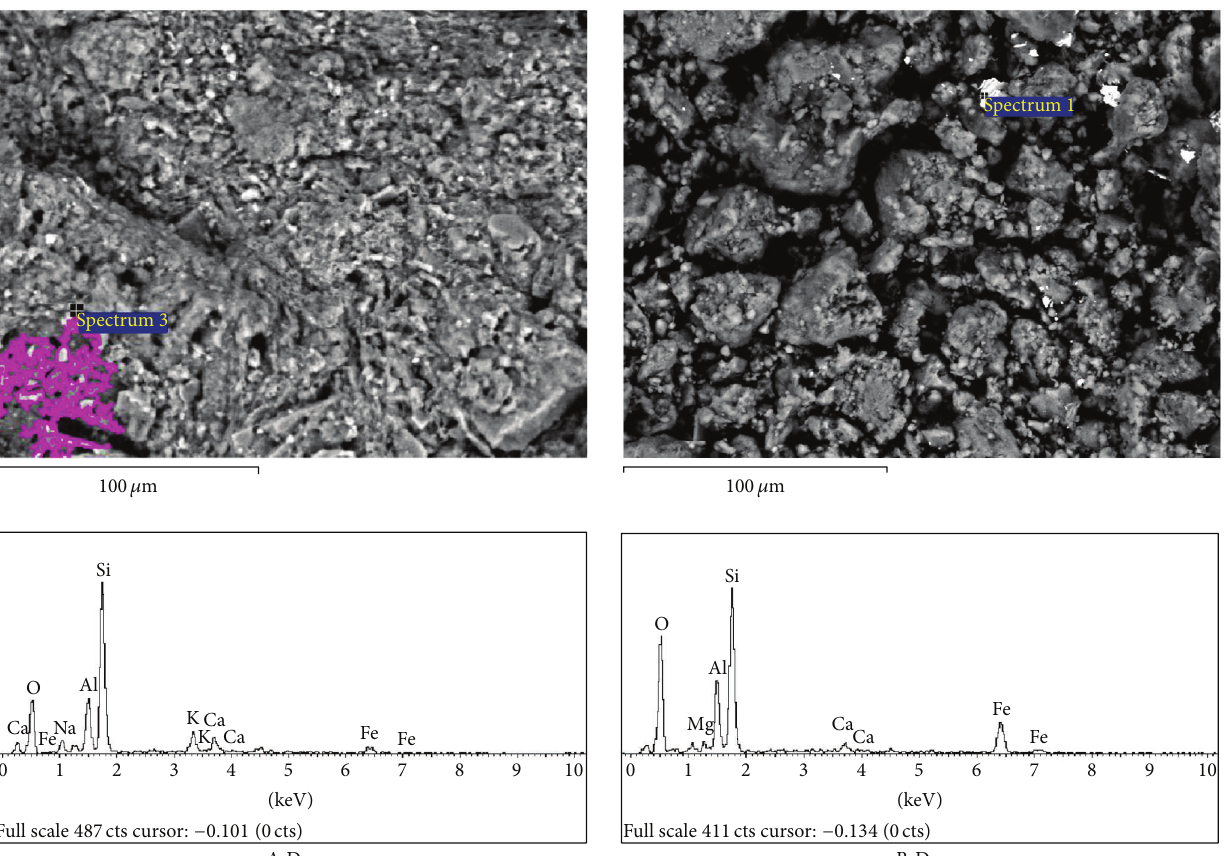
Figure 3: Elemental distribution images of samples A-D and B-D before